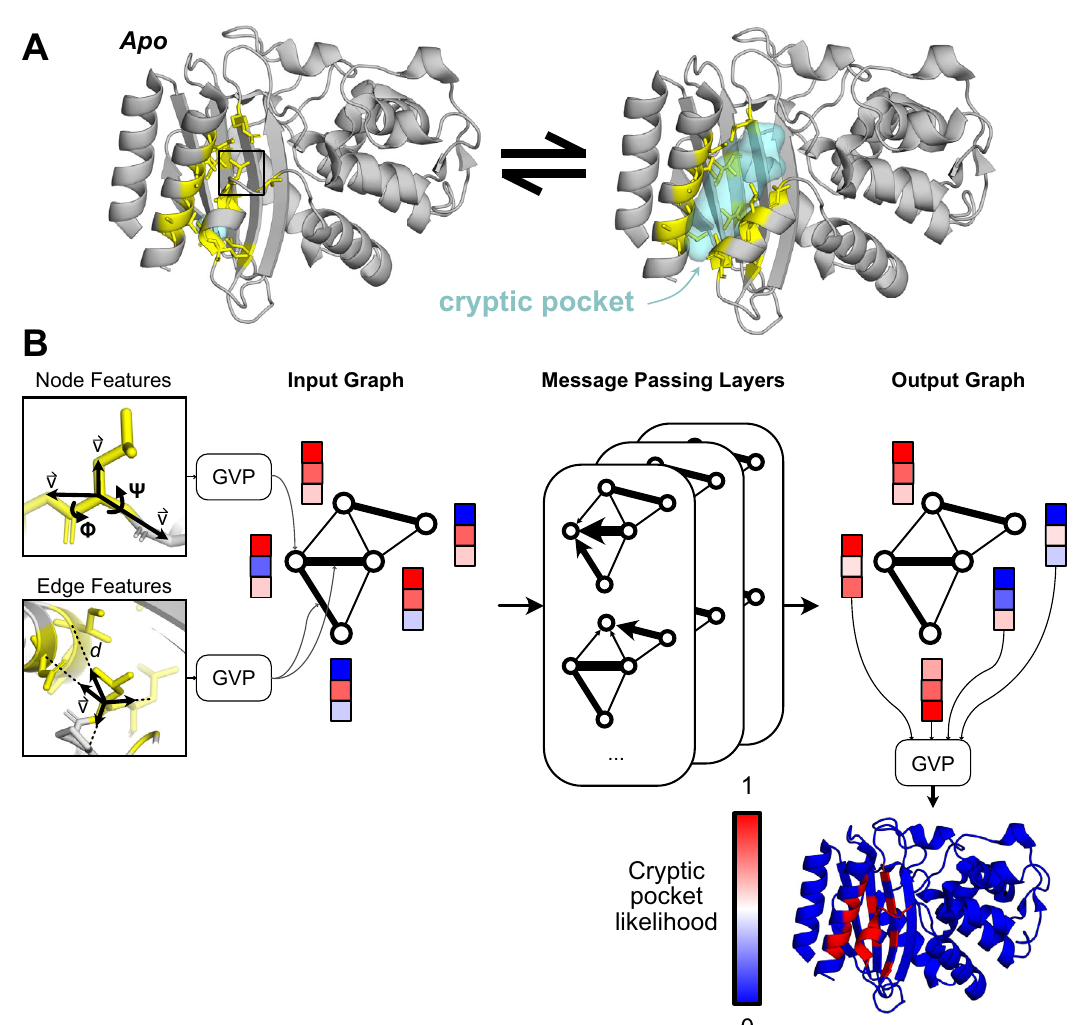
Fig. 1 | PocketMiner uses graph neural networks to predict cryptic pocket formation. A Proteins exist in an equilibrium between different structures, including experimentally derived structures that lack cryptic pockets (left, PDB ID 1JWP) 71 and those with open cryptic pockets (right, PDB ID 1PZO) 4 . Residues lining the cryptic pocket are shown in yellow sticks. B PocketMiner relies on a series of messagepassinglayerstoexchangeinformationbetweenresiduesandtogenerate encodings that can predict sites of cryptic pocket formation. On the left, we show thestructuralfeaturesthatarefedintoaninputgraphfollowingtransformationsby Geometric Vector Perceptron (GVP) layers. Node features include backbone